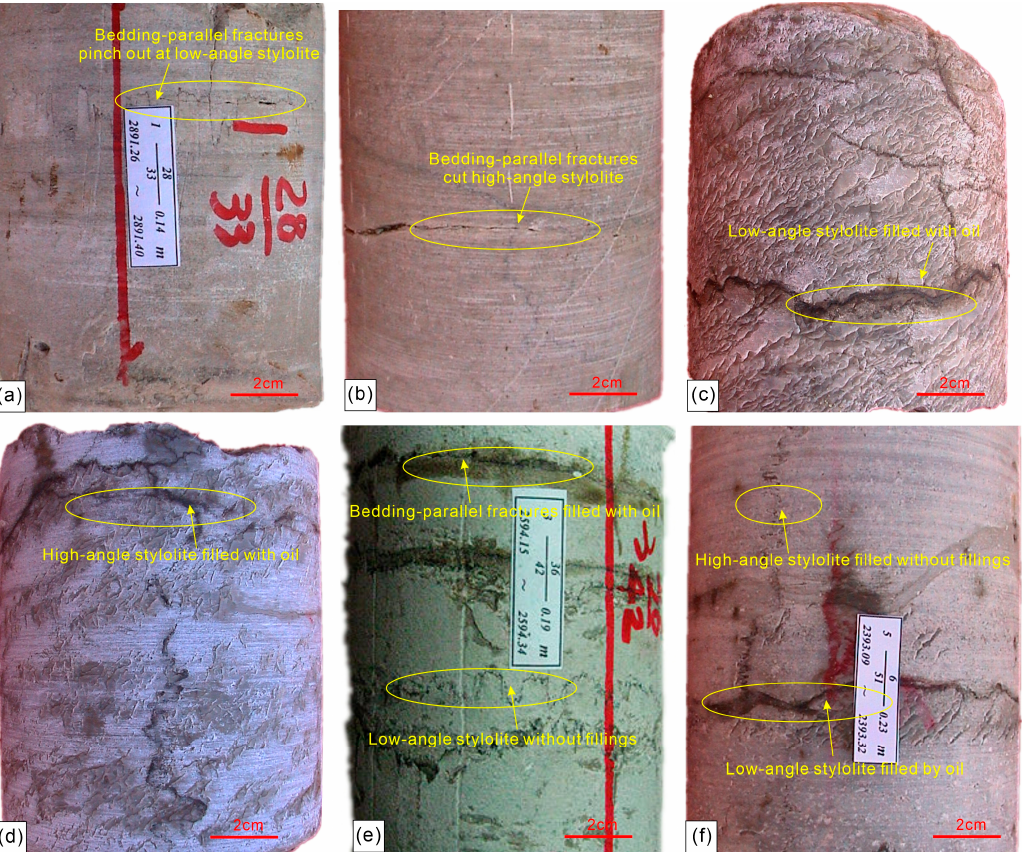
Figure 4. Characteristics of stylolites formed in different stages of the tectonic movements in the NT oilfield. ( a ) Low-angle stylolite formed in the first period of tectonic movement. ( b ) High-angle stylolite formed in the first period of tectonic movement. ( c ) Low-angle stylolite formed in the second period of tectonic movement. ( d ) High-angle stylolite formed in the second period of tectonic movement. ( e ) Low-angle stylolite formed in the third period of tectonic movement. ( f ) High-angle stylolite formed in the third period of tectonic movement. Table 1. Comparison of quantitative parameters of stylolites formed in different stages of the tectonic movements in the NT oilfield. Stylolite of the First Period Stylolite of the Second Period Stylolite of the Third Period Reference Reference Amplitude Amplitude Picture Picture Picture Low-angle stylolite (cm) 1.768 Figure 4a 0.852 Figure 4c 1.054 Figure 4e High-angle stylolite (cm) 0.448 Figure 4b 1.252 0.642 Figure 4f Based on the tectonic evolution of the basin in the study area, and the analysis results of the formation periods of the stylolites, the evolution pattern of stylolites in the study area was established (Figure